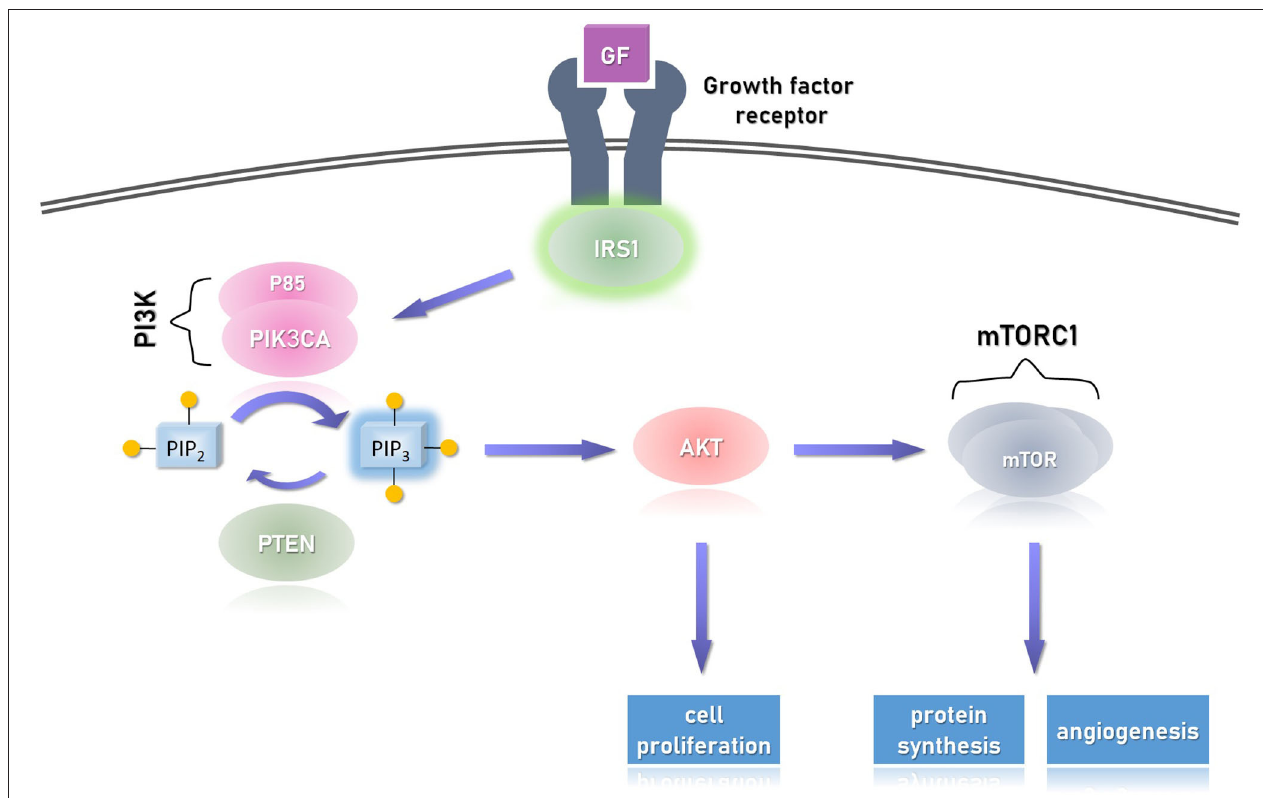
FIGURE 4 | The cellular response to growth factor (GF) via its receptor. Upon dimerization of the receptor, IRS1 (insulin receptor substrate 1) is phosphorylated and activates (via its SH2 domain) downstream effectors, particularly PI3K (phosphatidylinositol 3-kinase). The latter, in turn, phosphorylates the second messenger PIP2 (phosphatidylinositol 4,5-bisphosphate), resulting in the activation of AKT (protein kinase B), which activates the mTORC1 (mammalian target of rapamycin complex 1). This pathway promotes cellular proliferation (via AKT) and also promotes angiogenesis and protein synthesis via the mTORC1 effector. Overactivation of the catalytic unit of PI3K, called PIK3CA, or AKT1 may result in uncontrolled activation of this pathway and signal-independent (over) growth. The former is seen in PIK3CA-related overgrowth spectrum (PROS) and the latter in Proteus syndrome, both are segmental overgrowth syndromes. A similar picture can be seen with biallelic deactivation of PTEN which is a growth repressor, as it dephosphorylates PIP 3 back to its inactive form PIP 2 . This condition is seen in PTEN hamartoma tumor syndrome (PHTS). Not shown in the figure, but similar to PHTS, other growth repressors are the TSC1/2 complexes (tuber sclerosis complex), which inhibit mTORC1, but themselves are inhibited by AKT. The pathogenesis of variants in TSC1/2 is different, resulting in discrete tuberous growth of the cutaneous and CNS tissues, and predispose to variety of cancers. Of note, the PI3K/AKT/mTOR pathway is one pathway in which the growth factor